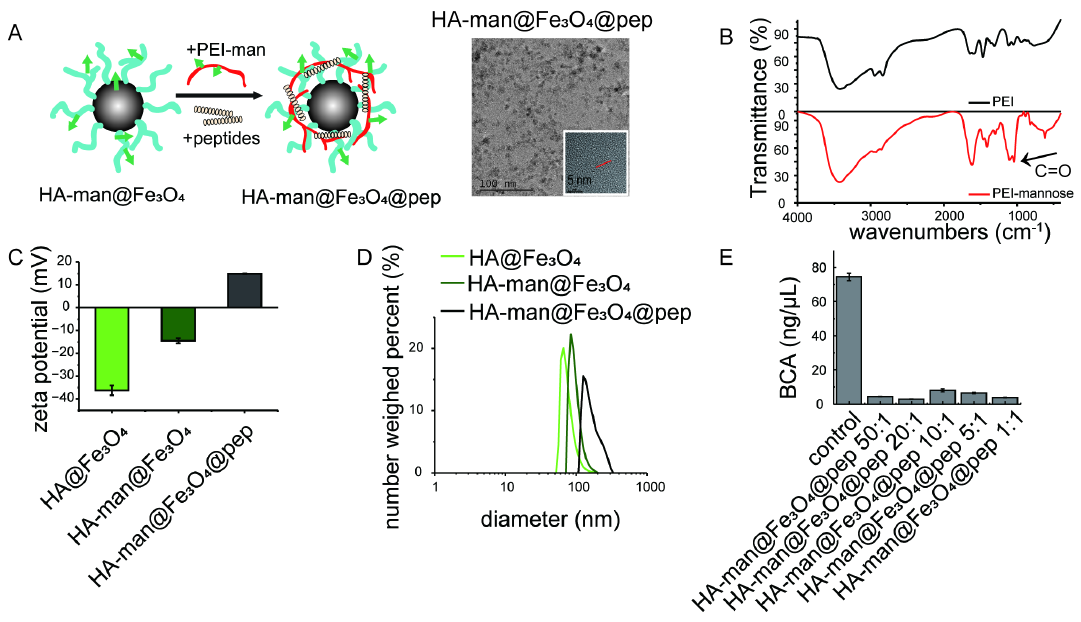
Figure 4. Characterization of HA-man@Fe3O4@pep nanocomplex. ( A ) Illustration of nanocomplex and TEM images of HA-man@Fe3O4@pep; ( B , C ) size distribution and zeta potentials of HA@Fe3O4, HA-man@Fe3O4, and HA-man@Fe3O4@pep; ( D ) infrared spectra of PEI and mannosylated PEI; ( E ) OVA concentration in the supernatant following adsorption. Error bars indicate at least three inde- pendent experiments. Table 2. Sequence of peptides in article.